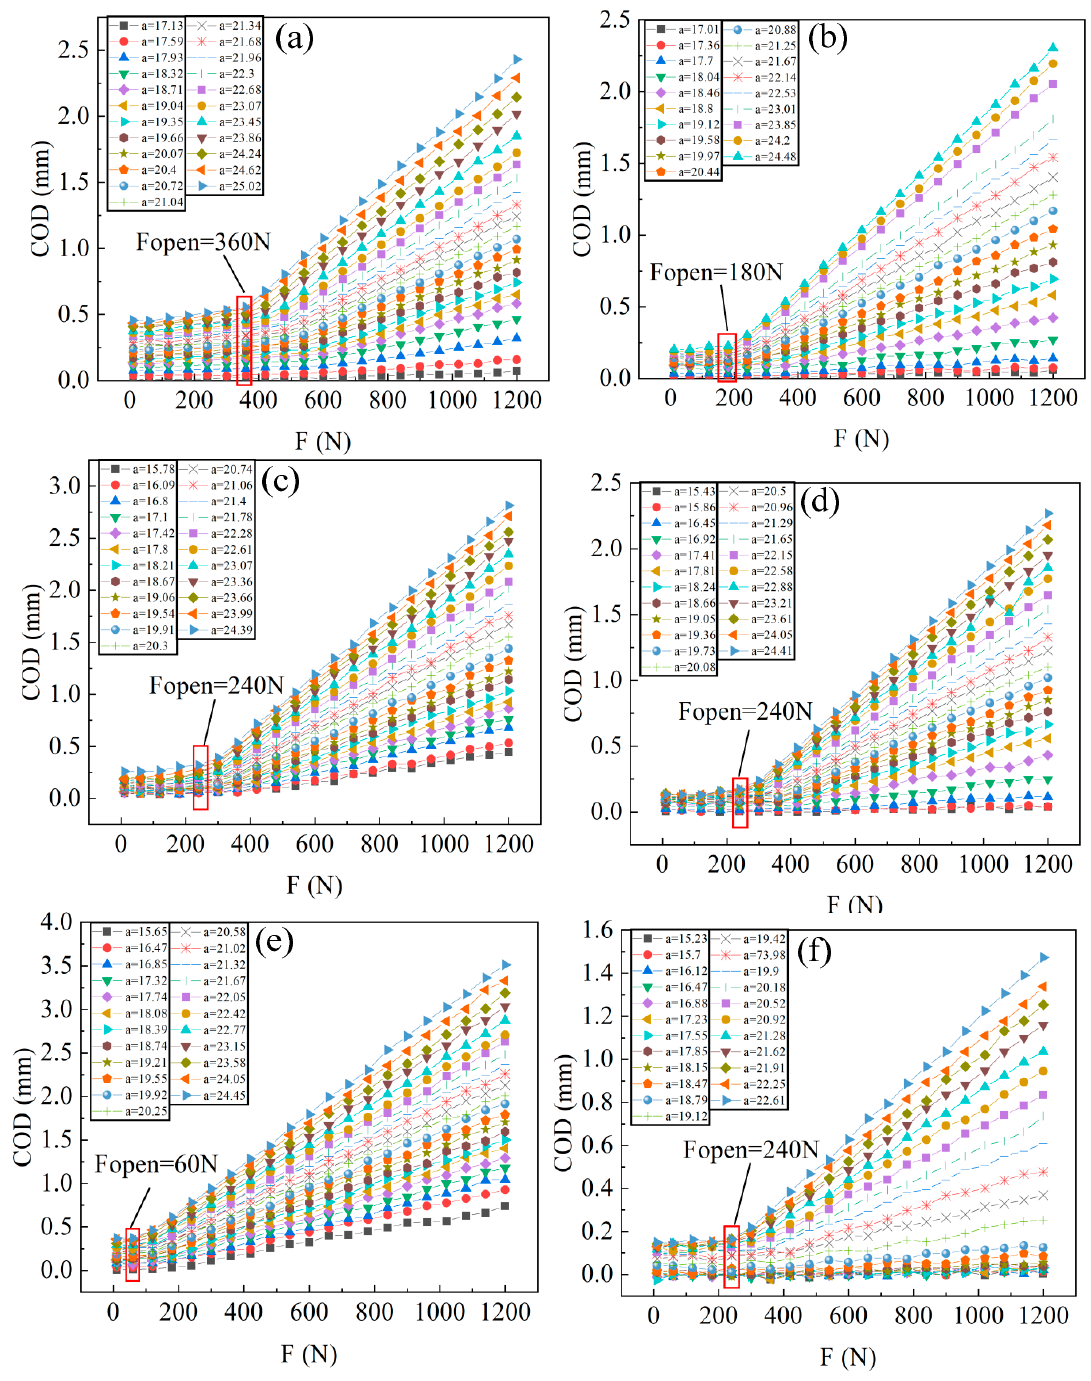
Figure 12. Determination of F open : ( a ) specimen B1; ( b ) specimen W1; ( c ) specimen B2; ( d ) specimen W2; ( e ) specimen B3; ( f ) specimen W3.